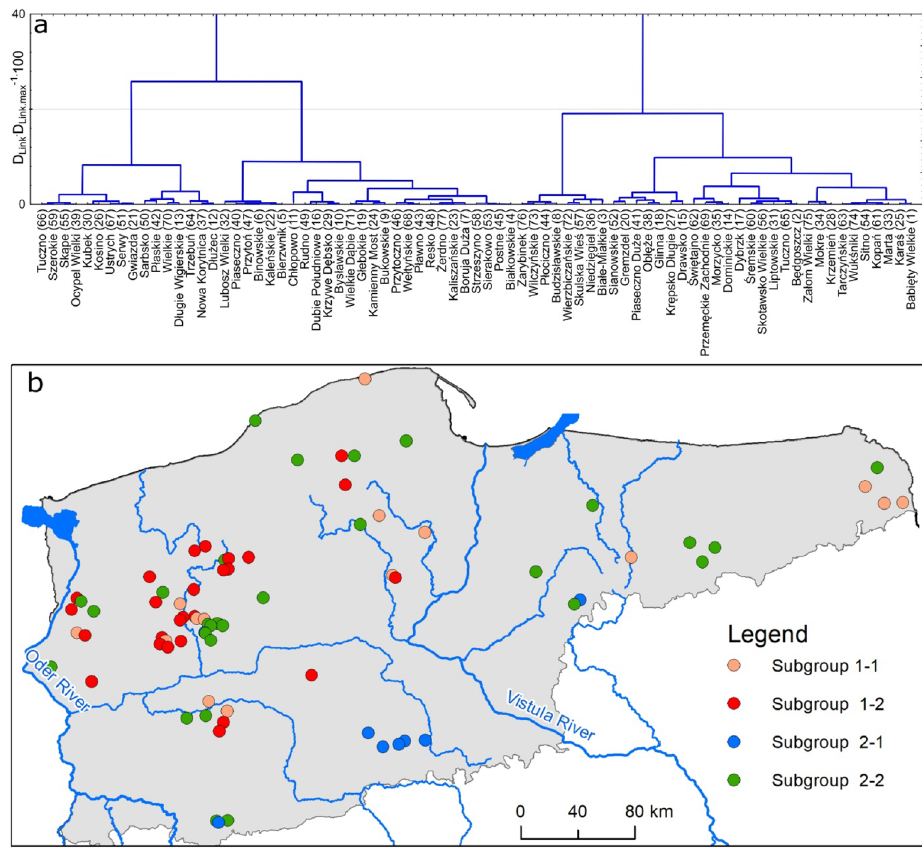
Figure 7. Results of the CA: division into groups of lakes by similarity of HM concentrations ( a ) and graphical presentation ( b ) [the ( b ) was generated in ArcMap 10.7, https:// deskt op. arcgis. com/ en/ arcmap/].